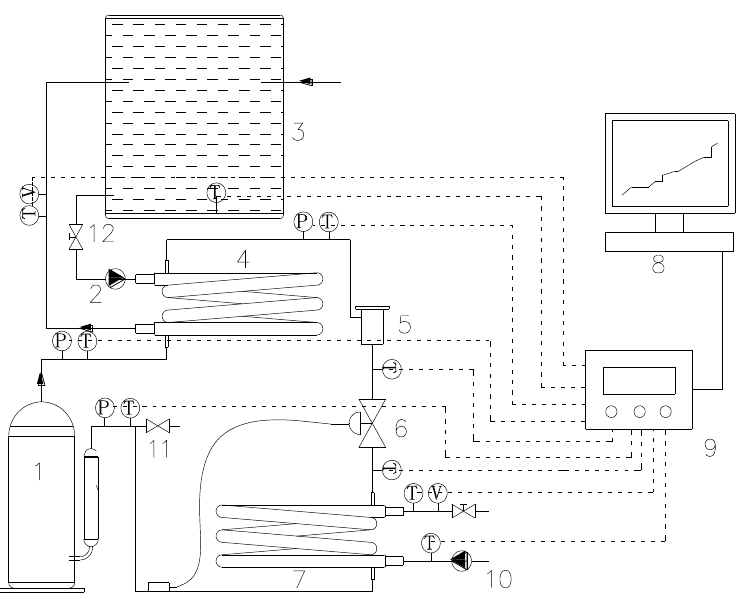
Figure 1. System diagram of water-source heat pump water heater (WSHPWH) system. Key: T: thermocouples; P: pressure gauge; V: water flow meter. 1. Compressor, 2. Pump, 3. Water